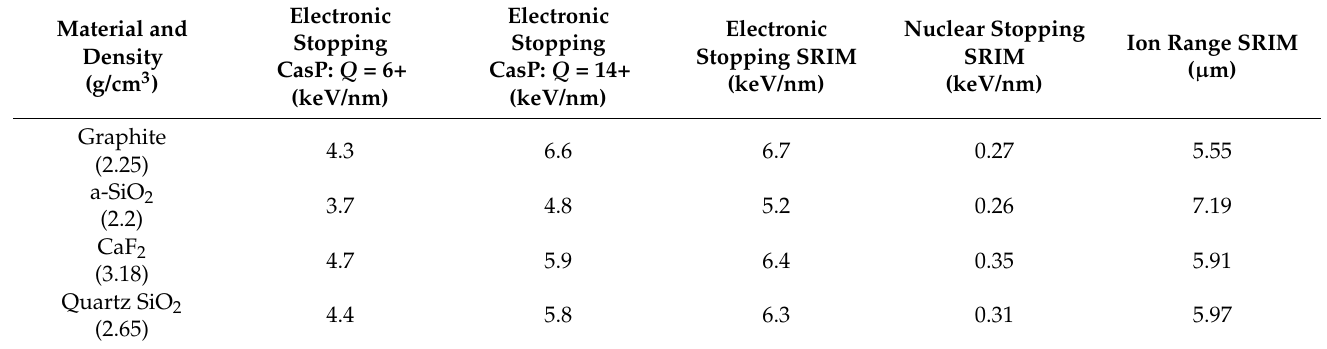
Table 1. The 23 MeV I irradiation parameters calculated by CasP 5.2 [20] and SRIM 2013 codes